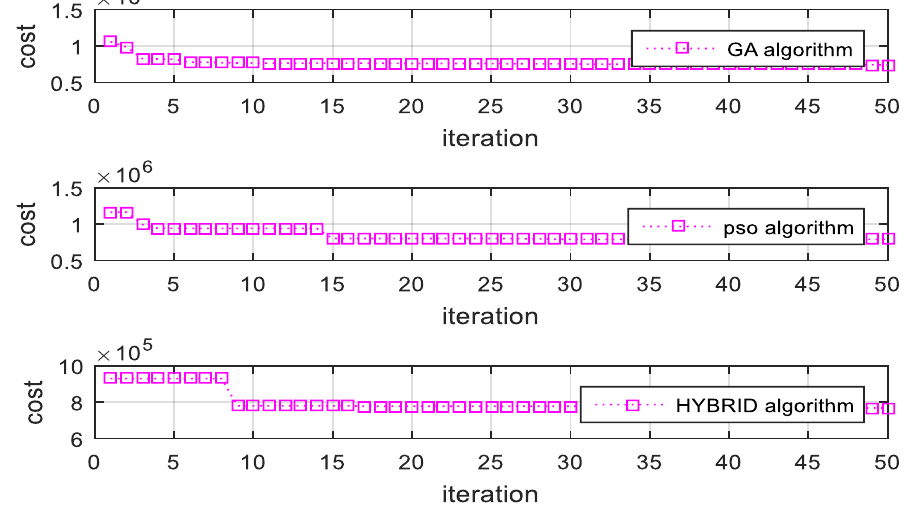
Figure 5. The cost function for GA, PSO, and hybrid-based optimization technique using PEM based method for scenario-1.